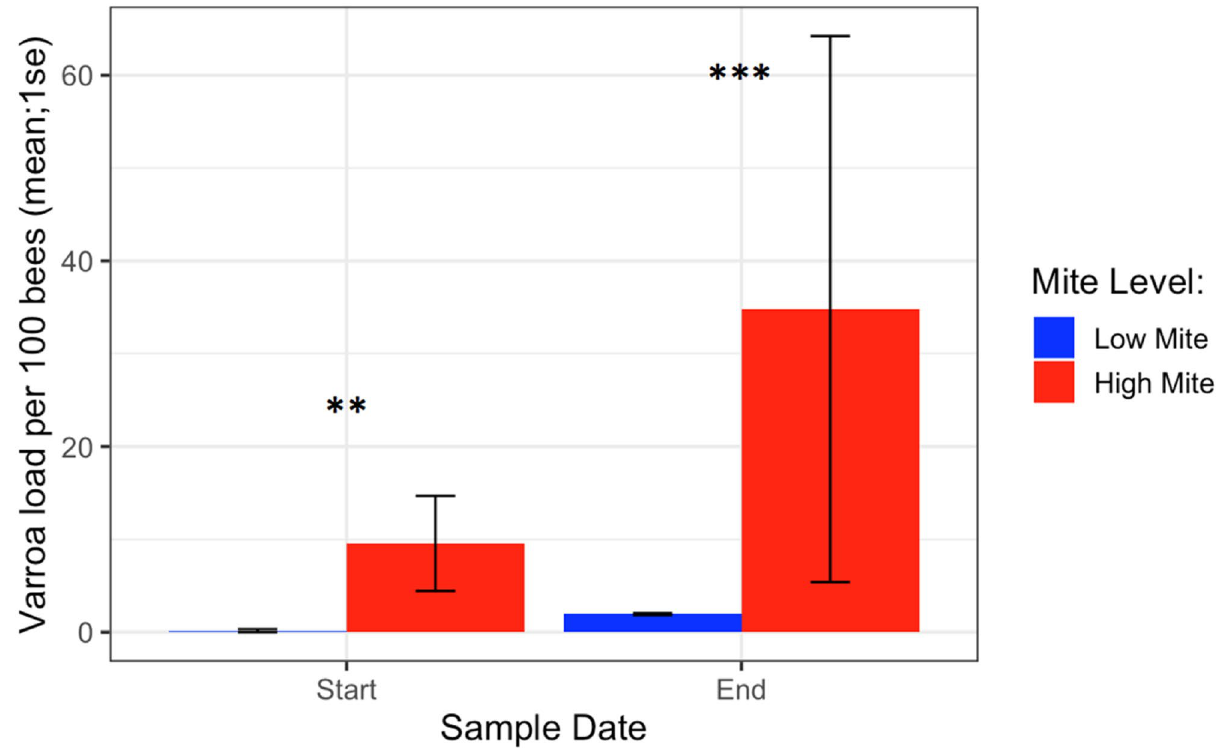
Figure 10. Varroa loads in low vs. high mite donor colonies at the start and end of the experiment. High mite colonies had significantly more mites than low mite colonies throughout the study ( χ 2 **p < 0.01, ***p < 0.001).